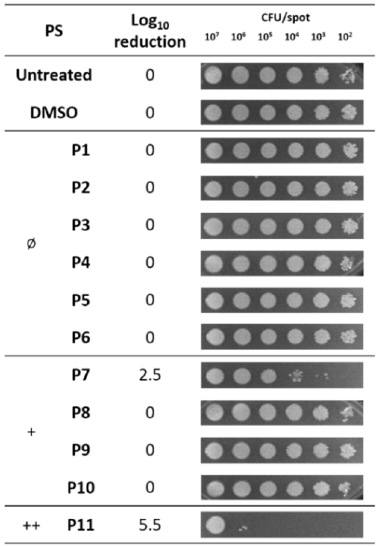
Figure 3. Photodynamic activity of diaryl-porphyrins on P. aeruginosa PAO1 evaluated by the photo-spot test. The neutral (Ø), monocationic (+) and dicationic (++) porphyrins were administered at a final concentration of 10 µ M to samples of P. aeruginosa PAO1 at decreasing concentrations (from 10 9 up 10 4 CFU/mL). After 1 h dark incubation, volumes of ~5 µ L of each sample were replica plated on LB agar and irradiated under 410 nm light (20 J/cm 2 ). Cells were incubated at 37 ◦ C O/N and growth spots were checked and representative images are reported in the last column. Log10 reduction values represent the mean of at least three independent